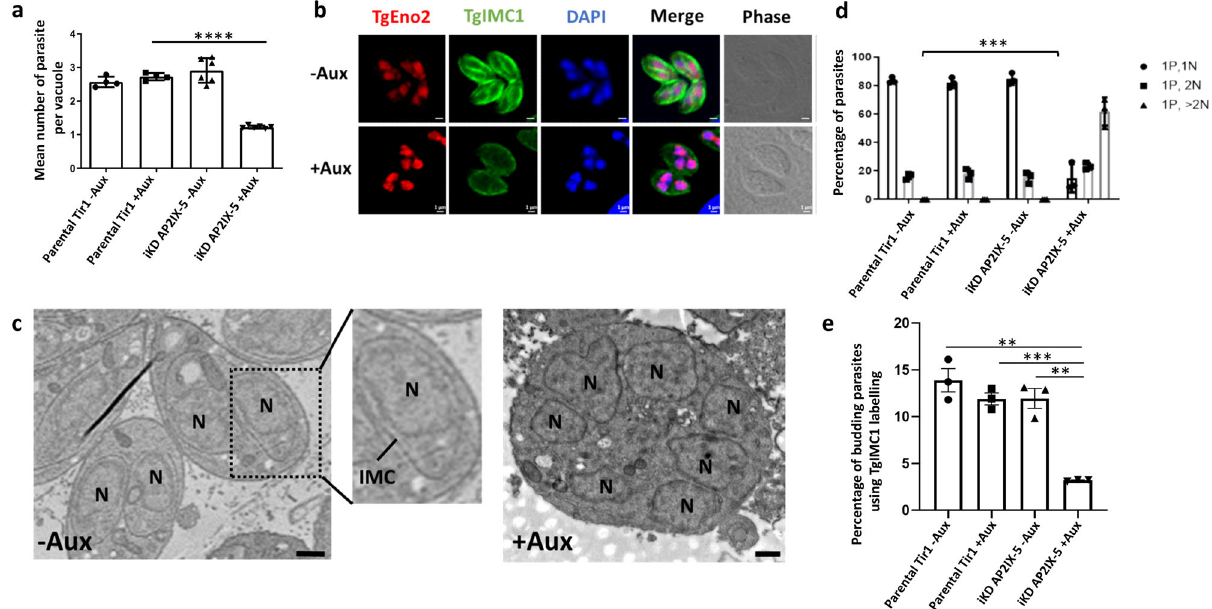
Fig. 2 Characterization of TgAP2IX-5 iKD parasite. a Growth assay for parental and iKD TgAP2IX-5 strains in the absence and presence of auxin treatment for 24 h. The number of parasites per vacuole was measured and the average number of parasites is represented within the graph. A total of 100 vacuoles were counted for each replicate. A Student ’ s t -test was performed; two-tailed p -value: **** p < 0.0001; mean ± s.d. ( n = 4 independent experiments). b Confocal imaging of iKD TgAP2IX-5 labelled with TgEno2 (red) and TgIMC1(green) in the presence and absence of auxin treatment. Auxin was added 24 h post-infection. DAPI was used to stain the nucleus. Scale bar is indicated at the lower right side of each image. c Electron microscopy scans demonstrating the structural morphology of the nucleus in iKD TgAP2IX-5 parasite in the absence and presence of auxin. (N) represents the nucleus. Two daughter parasites are formed within each mother parasite in absence of auxin. Multinucleated parasites are visible in presence of auxin. Scale bar (500 nm) is indicated at the lower right side in the TEM images. d Bar graphs representing nucleus per parasite counts for parental and iKD TgAP2IX-5 strains in the absence and presence of auxin (12 h treatment). P stands for parasites and N stands for nuclei. A Student ’ s t -test was performed comparing mean percentage of multinucleated parasite between the control (Parental in absence of auxin) and iKD TgAP2IX-5 in the presence of auxin, two-tailed p -values: *** p = 0,0004; mean ± s.d. ( n = 3 independent experiments). e Bar graph representing the percentage of daughter parasite formation in the absence and presence of 6 h of auxin treatment using TgIMC1 labelling, A Student ’ s t -test was performed, two-tailed p -values: *** p = 0.0002, ** p = 0.0012; mean ± s.d. ( n = 3 independent